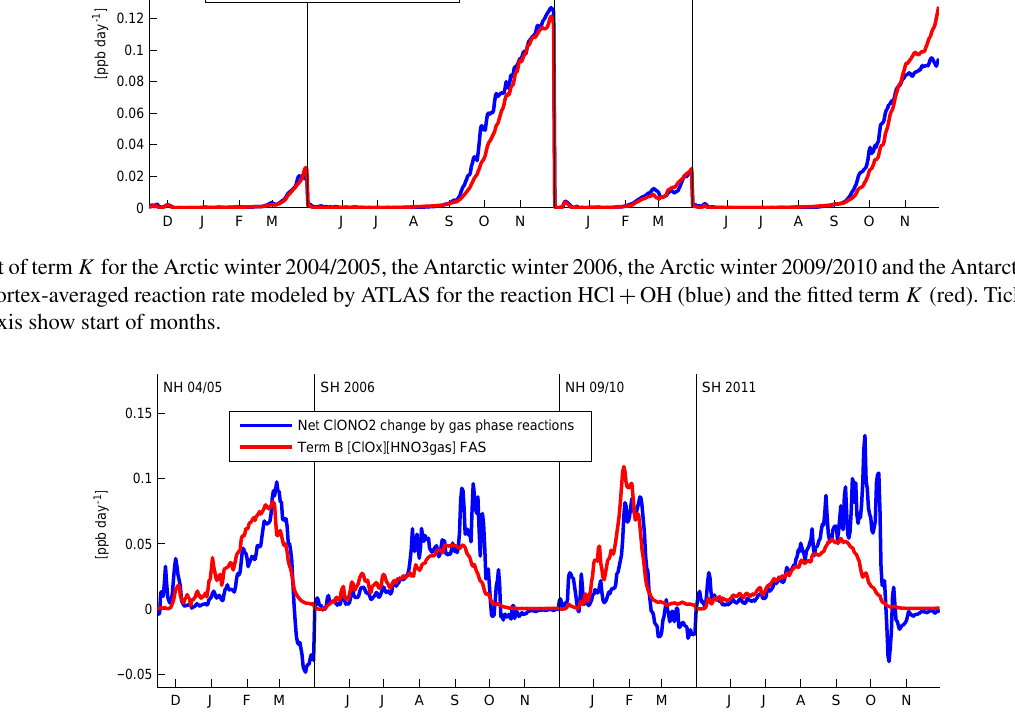
Figure 10. Fit of term B for the Arctic winter 2004/2005, the Antarctic winter 2006, the Arctic winter 2009/2010 and the Antarctic winter 2011 at 54hPa. Sum of the vortex-averaged reaction rates modeled by ATLAS for the reactions ClONO 2 + hν (both channels), ClO + NO 2 , ClONO 2 + Cl, ClONO 2 + OH and ClONO 2 + O (blue) and the fitted term B (red). Tick marks on the horizontal axis show start of